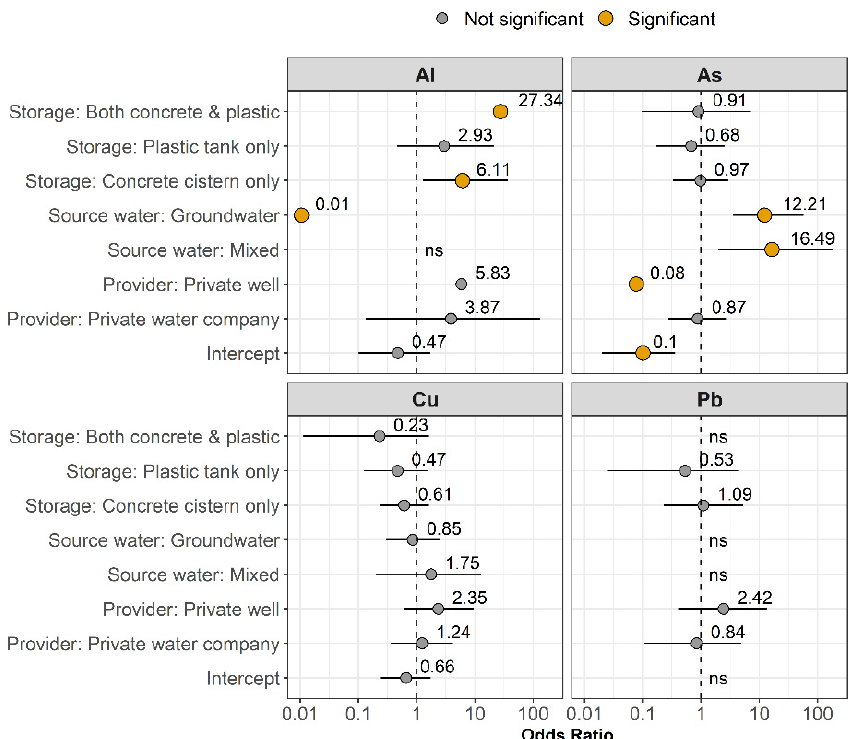
Figure 5. Odds ratios and 95% confidence intervals from multiple logistic regression analyses to evaluate exceedances of the Guatemalan health-based MPL (for Al, As, and Pb) and aesthetic MAL (for Cu). Large orange dots indicate significant predictors. As exceedances were positively associated with groundwater and mixed source waters but negatively associated with private well water. Al exceedances were positively associated with the presence of a concrete cistern but negatively associated with groundwater. Pb and Cu exceedances were not significantly associated with any predictors. Intercept values show the odds of exceedance when all predictors are set to their reference value (see Table S4). Household income, housing type, building age, home ownership, and frequency of water shut offs were not significant in any models. Variables labeled “ns” were not significant and exceeded the plotting boundaries. See Table S4 for more detail.